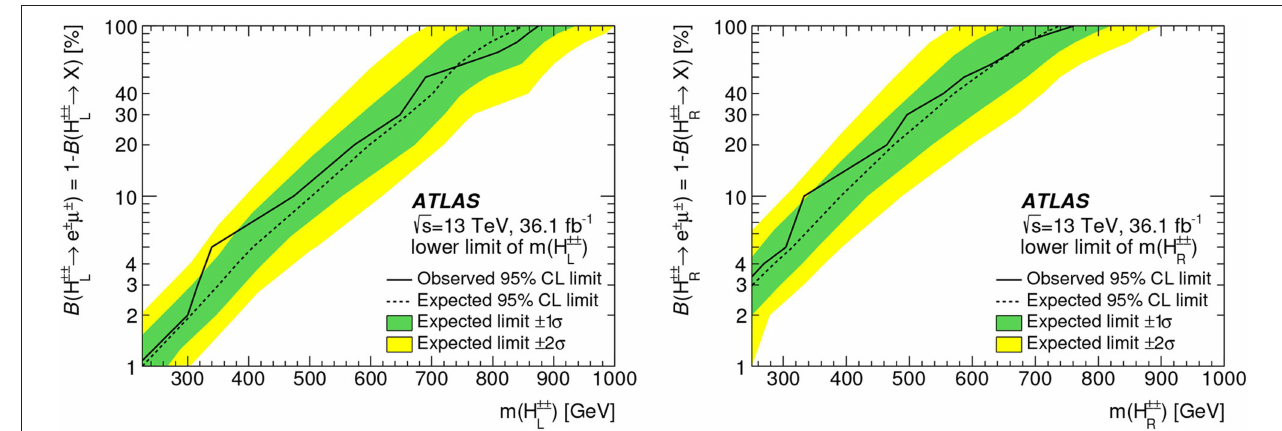
e ± µ ± ). Reproduced from ATLAS →